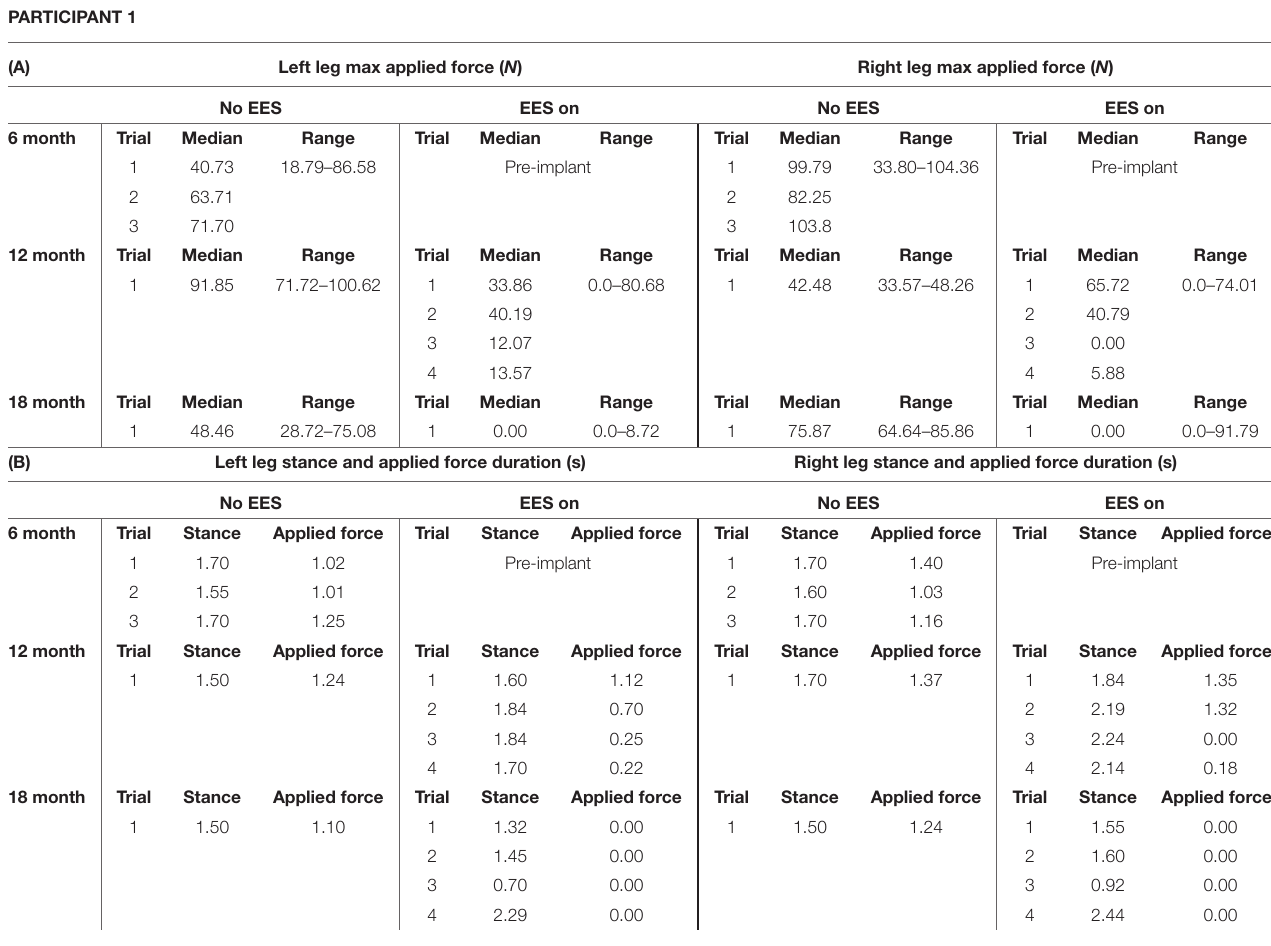
TABLE 1 | Participant 1: (A) maximum applied force values for left and right leg including all trials at month 6, 12, and 18 and (B) stance and applied force duration values for left and right legs including all trials at month 6, 12, and